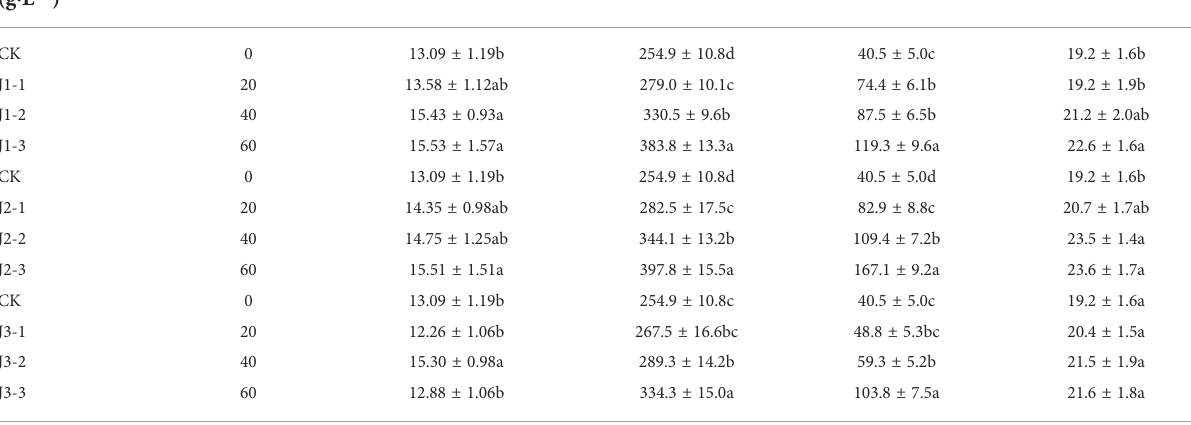
TABLE 4 Responses of antioxidant enzyme activity and membrane lipid peroxidation product content in the roots of sugarcane seedlings to different root aqueous extracts. Treatment and